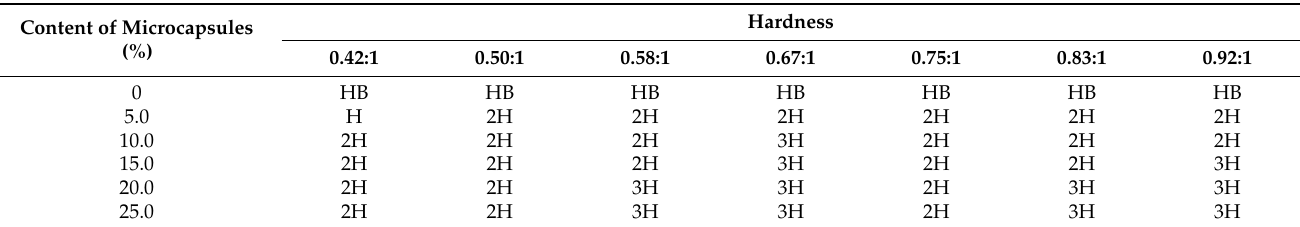
Table 3. Variation of hardness of water-based topcoat paint film.